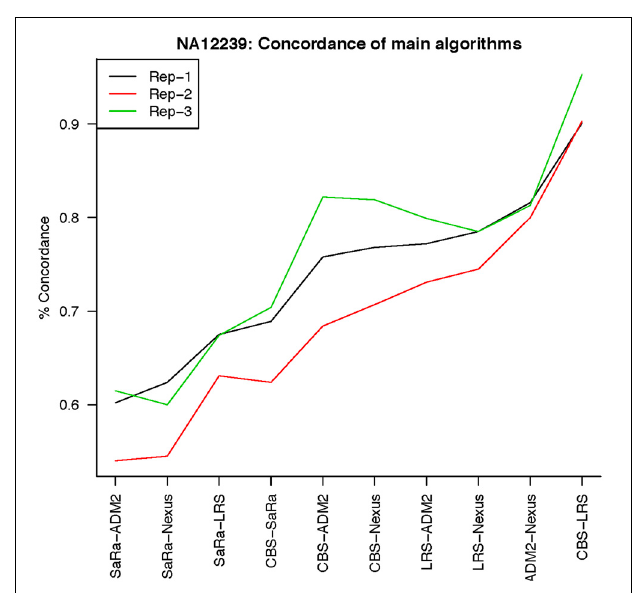
FIGURE 10 | This is % Concordance between methods for HapMap sample NA12239. Percent concordance is defined as the number of probes called as a CNV on two algorithms divided by the geometric mean of the total number of probes called significant by the two